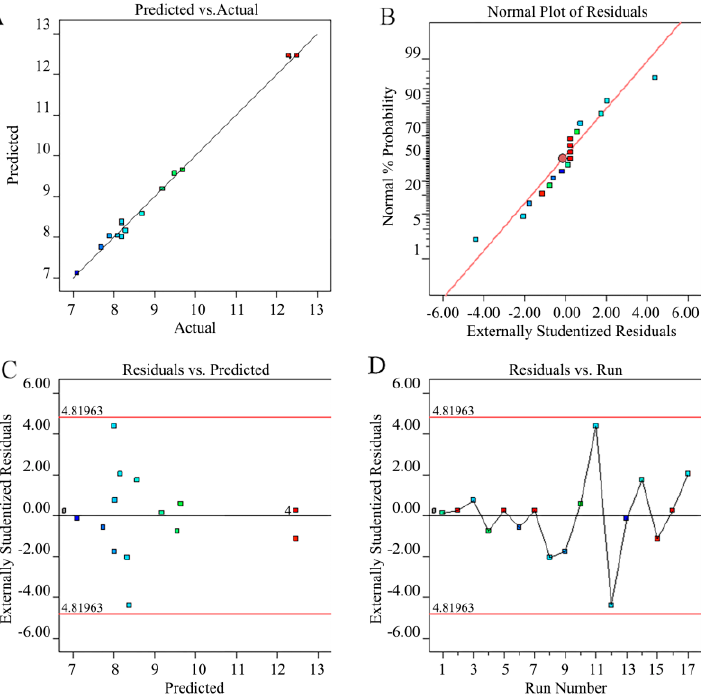
Figure 2. ( A ) Relationship between the predicted and test values, ( B ) normal error diagram of the RSM experiment value, ( C ) RSM residual and model prediction diagram, and ( D ) figure of residue versus the number of runs. The different colors represent the dispersion of the discrete random variables.